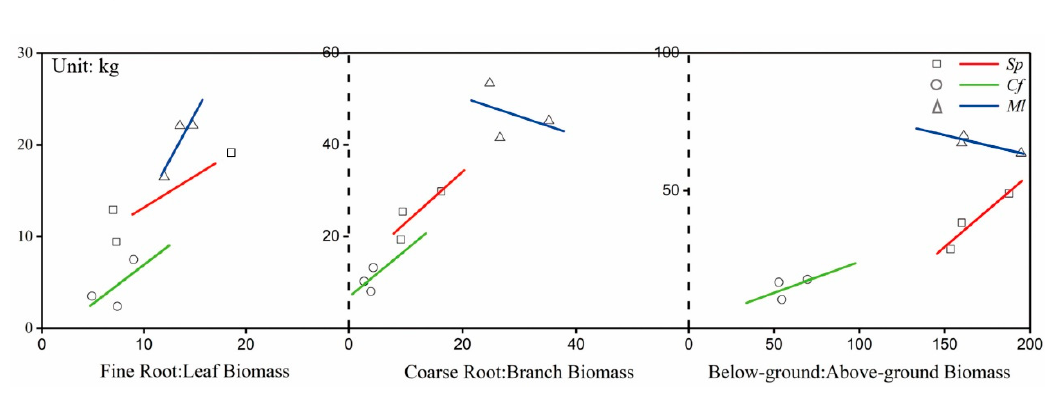
Three types of root:shoot ratio were calculated: (1) fine root:leaf biomass ratio, (2) coarse root:branch biomass ratio and (3) below-ground:above-ground biomass ratio (Figure 5). All the root:shoot ratios were significantly di ff erent ( p < 0.05) and Ml was the highest, which had a larger proportion of root system than Sp and Cf . Among the three ratios, the below-ground:above-ground biomass ratio of Ml showed the greatest di ff erence ( p < 0.01).